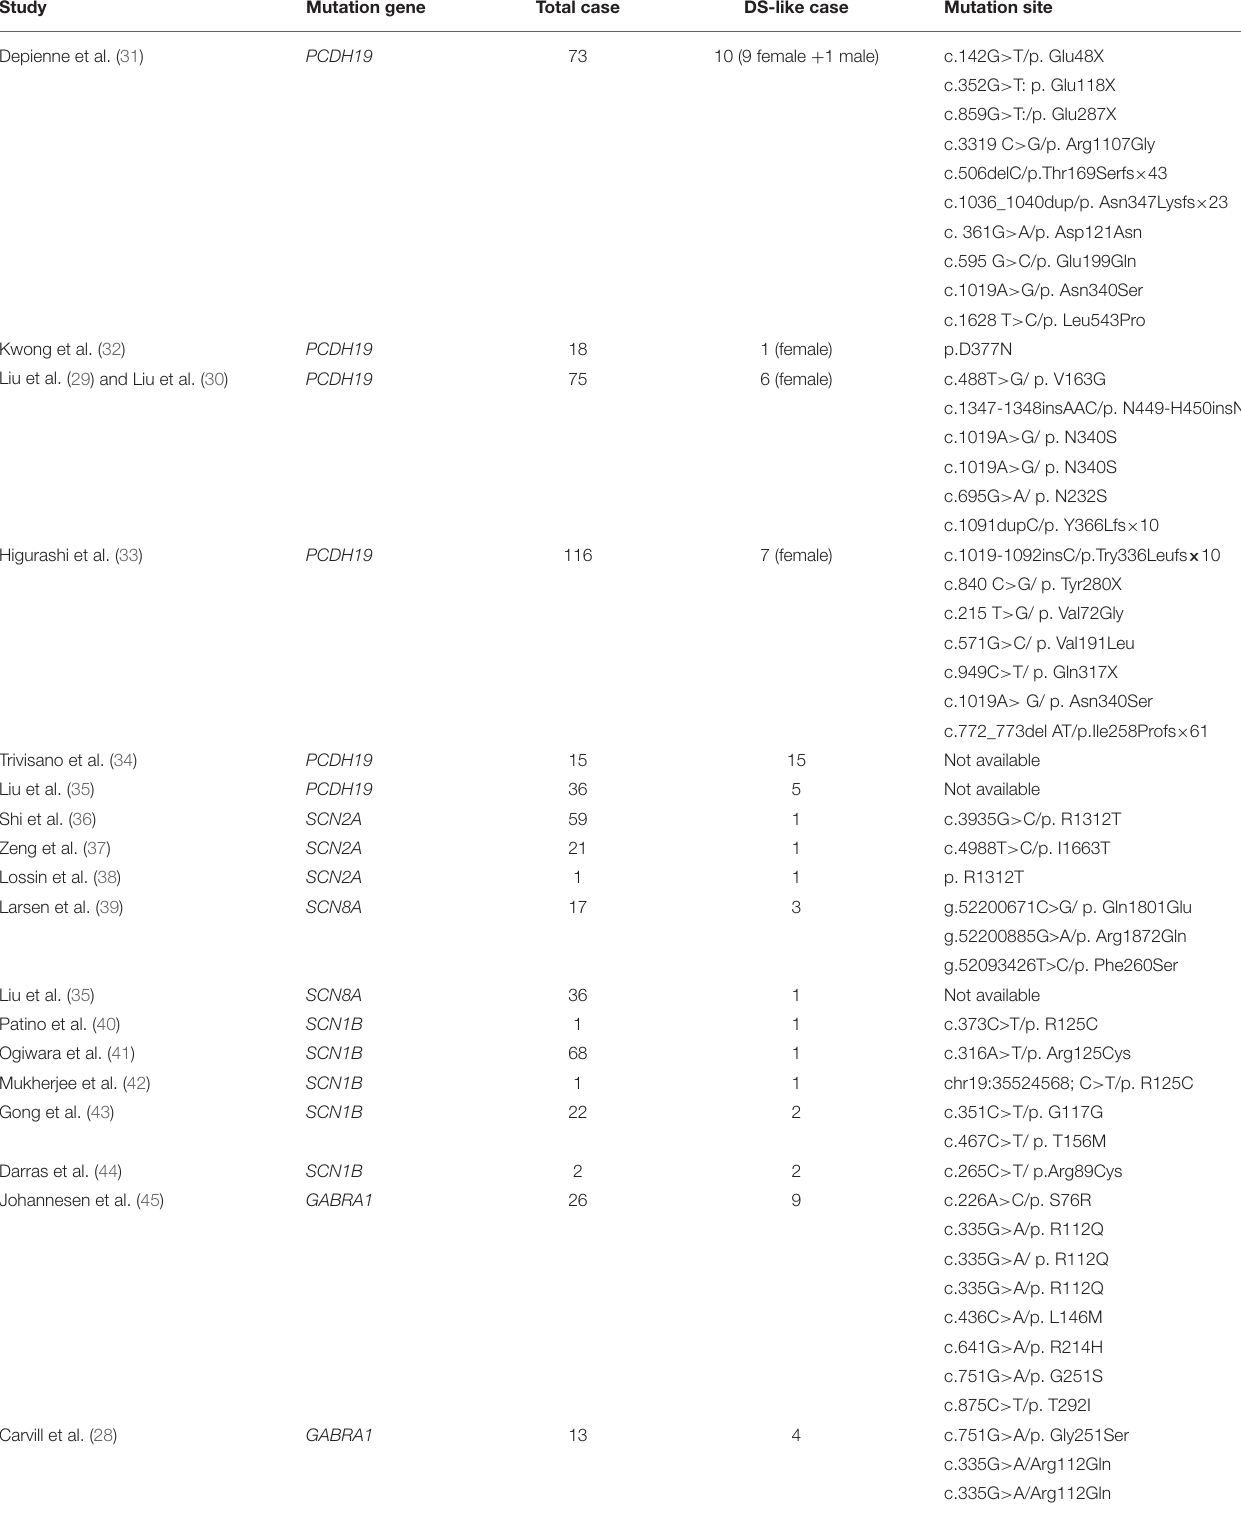
TABLE 1 | The data of DS-like caused by multiple single-gene mutations that met the inclusion criteria were summarized.